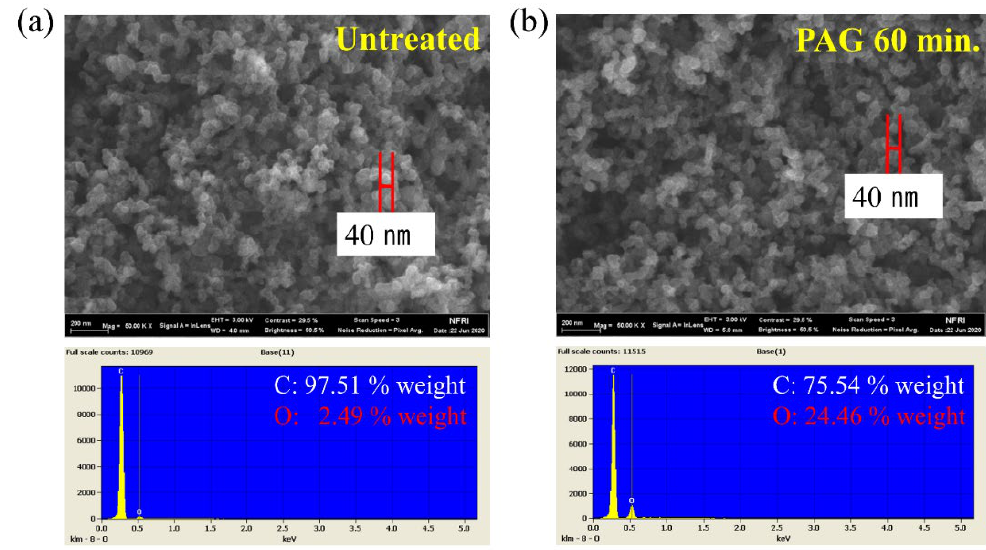
Figure 6. Field emission scanning electron microscopes (FE-SEM) images and energy-dispersive X-ray spectroscopy (EDX) elemental analysis were taken for ( a ) untreated carbon powder, and ( b ) carbon powder treated for 60 min with PAG.